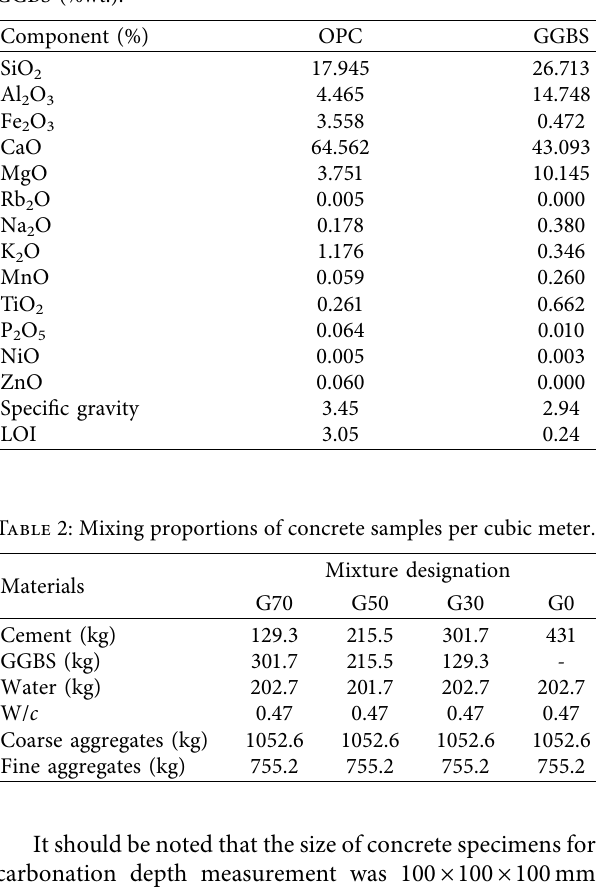
Table 1: Chemical composition and specific gravity of cement and GGBS (%wt.).